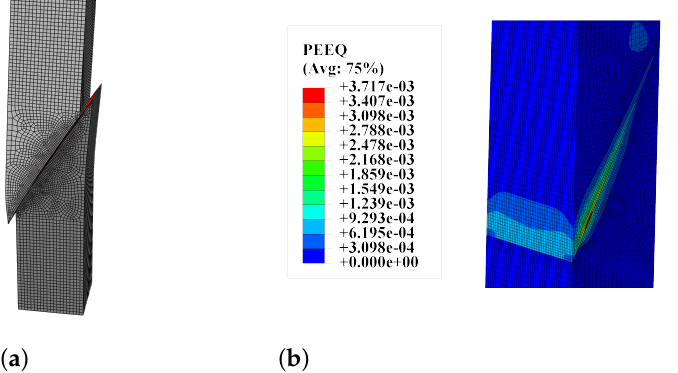
Figure 17. ( a ) The slant-shear test—deformed mesh. ( b ) The slant-shear test—map of the equivalent plastic strain in compression PEEQ.